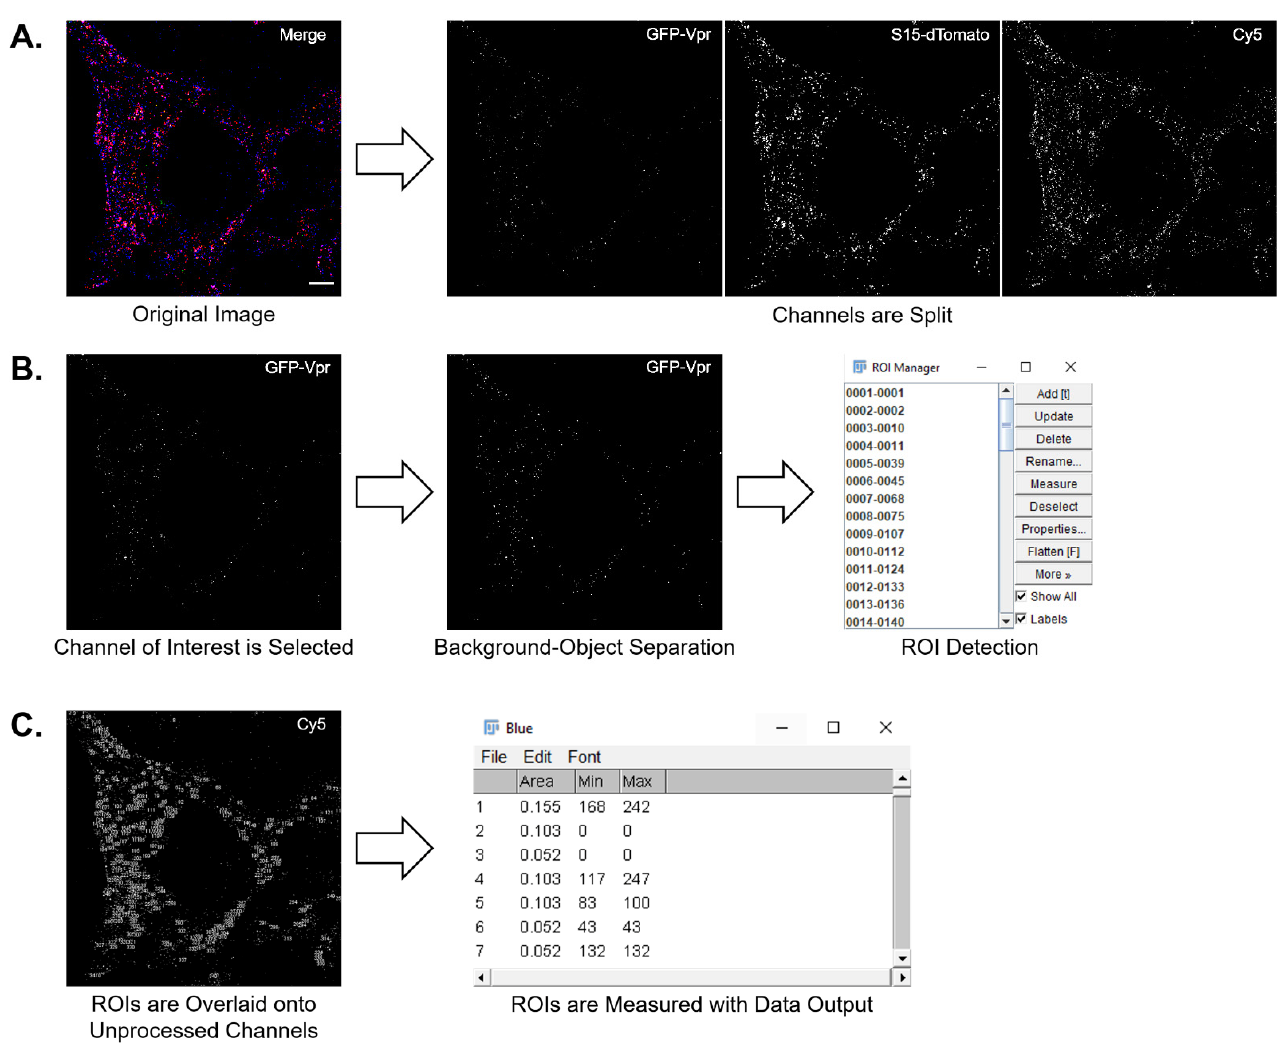
Figure 3. Macro workflow. ( A ) A background adjusted multicolor image is split into individual channels, each representing a single fluorescent signal. In this example, green, red, and blue correspond to GFP, dTomato, and Cy5, respectively. The white scale bar in the Merge panel is 10 µm. Image brightness has been enhanced for signal visibility. ( B ) The channel for particle location is selected and undergoes auto-thresholding. Remaining objects are identified and stored as ROIs. ( C ) The stored ROIs are overlaid onto the unadjusted blue and red channels before measuring each ROI individually. Data can then be exported to a separate software for further analysis.